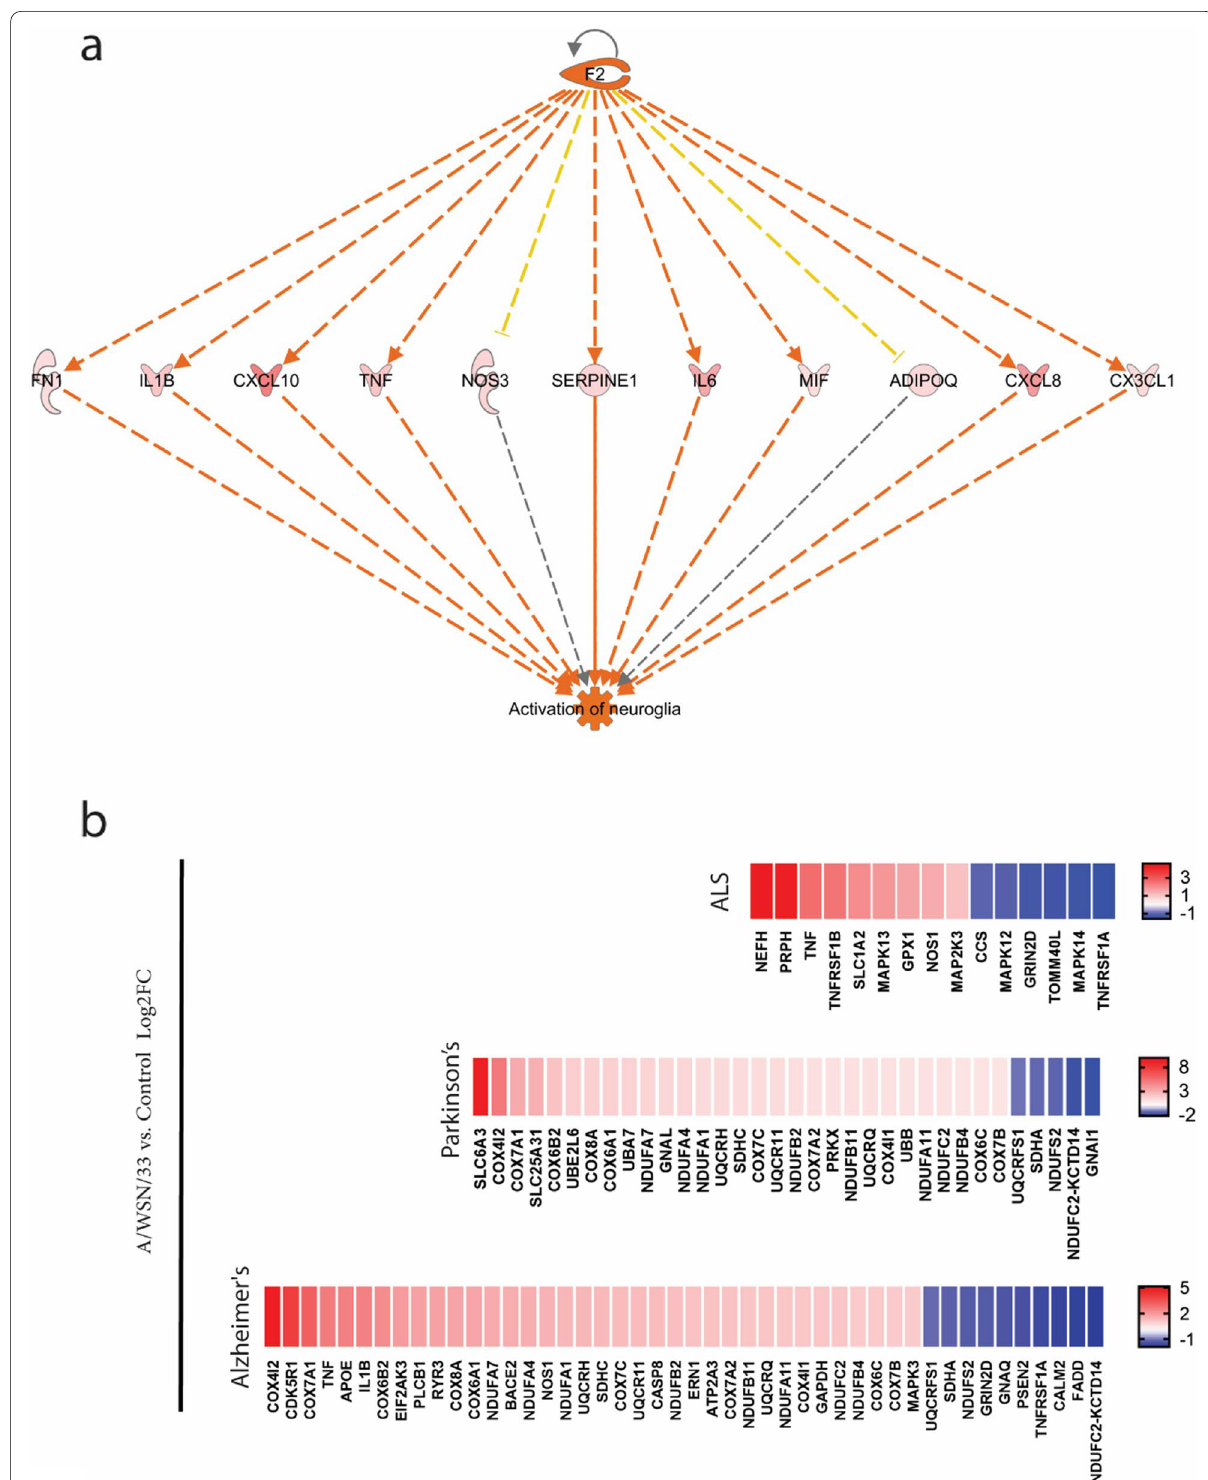
Fig. 11 Enrichment analysis indicating neurological disorders. a The IPA regulator effects analysis shows that the F2 upstream regulator and its downstream effects indicate a potential activation for the neuroglia in hBMECs at 12 hpi. The regulator effects algorithm generates hypotheses that explain how the activation or inhibition of regulators leads to an increase or decrease of function. b the heatmaps reveal the genes participating in neurodegenerative disease pathways enriched and sorted according to Log2FC ratios in the DEGs